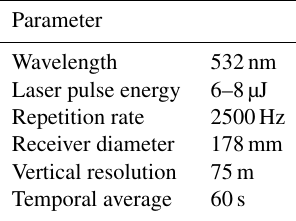
Table 1. Instrument